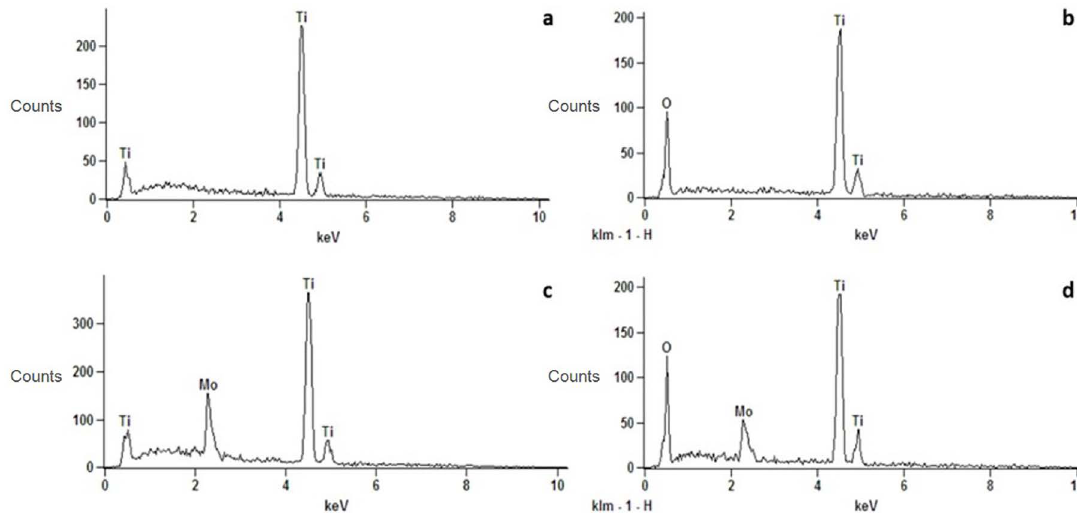
Figure 2. EDX of the: (a) Ti-P, (b) Ti-L, (c) TiMo-P and (d)